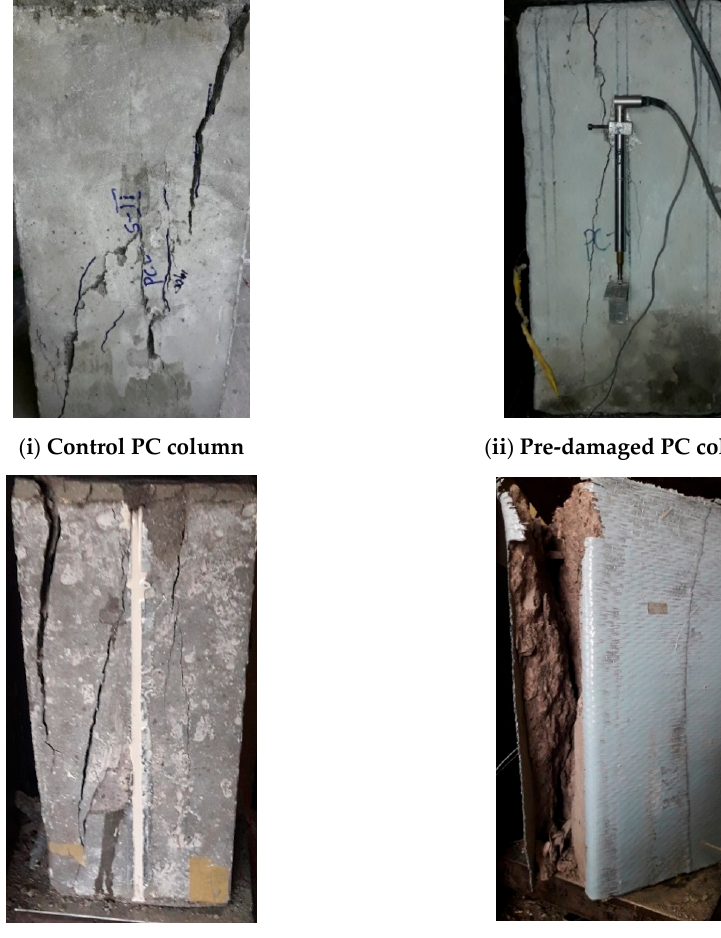
Figure 7. Failure Modes of Pre-damaged PC Columns with and without FRP Strengthening.